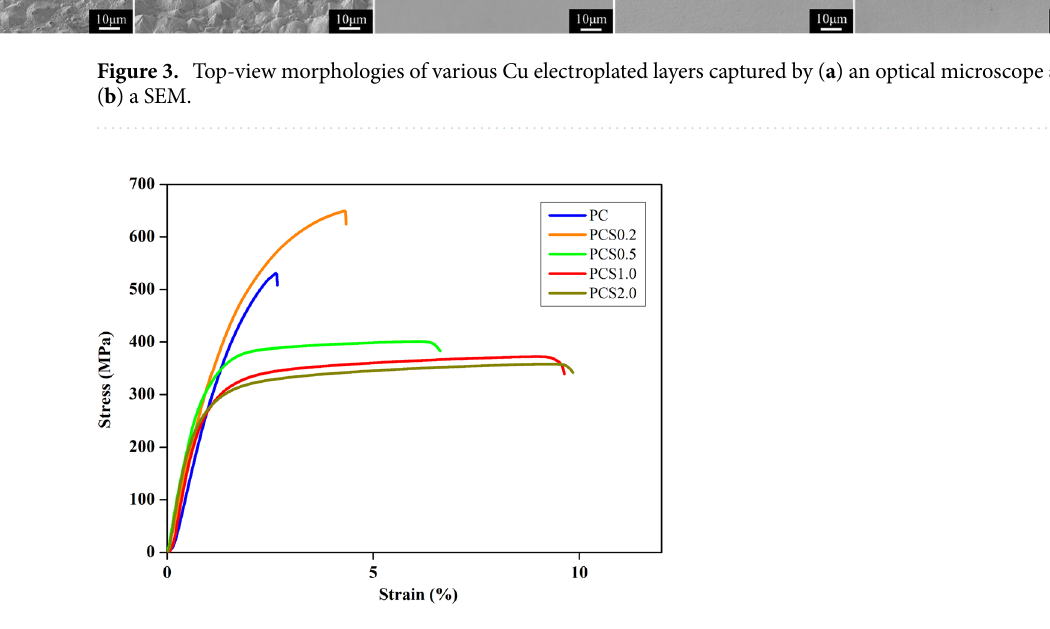
Figure 4. Stress–strain curves of the Cu electroplated layers obtained through tensile tests and labelled as ( a ) PC, ( b ) PCS0.2, ( c ) PCS0.5, ( d ) PCS1.0, and ( e )